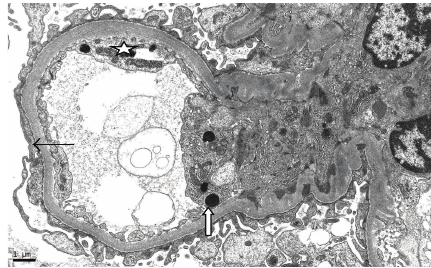
Figure4:Ultrastructuralfindingsoffocalsegmentalglomeruloscle- rosis showing podocyte foot process effacement (thin black arrows) and protein reabsorption droplet (white arrow). Endothelial cells show tubuloreticular inclusions in the upper right-hand corner (star).